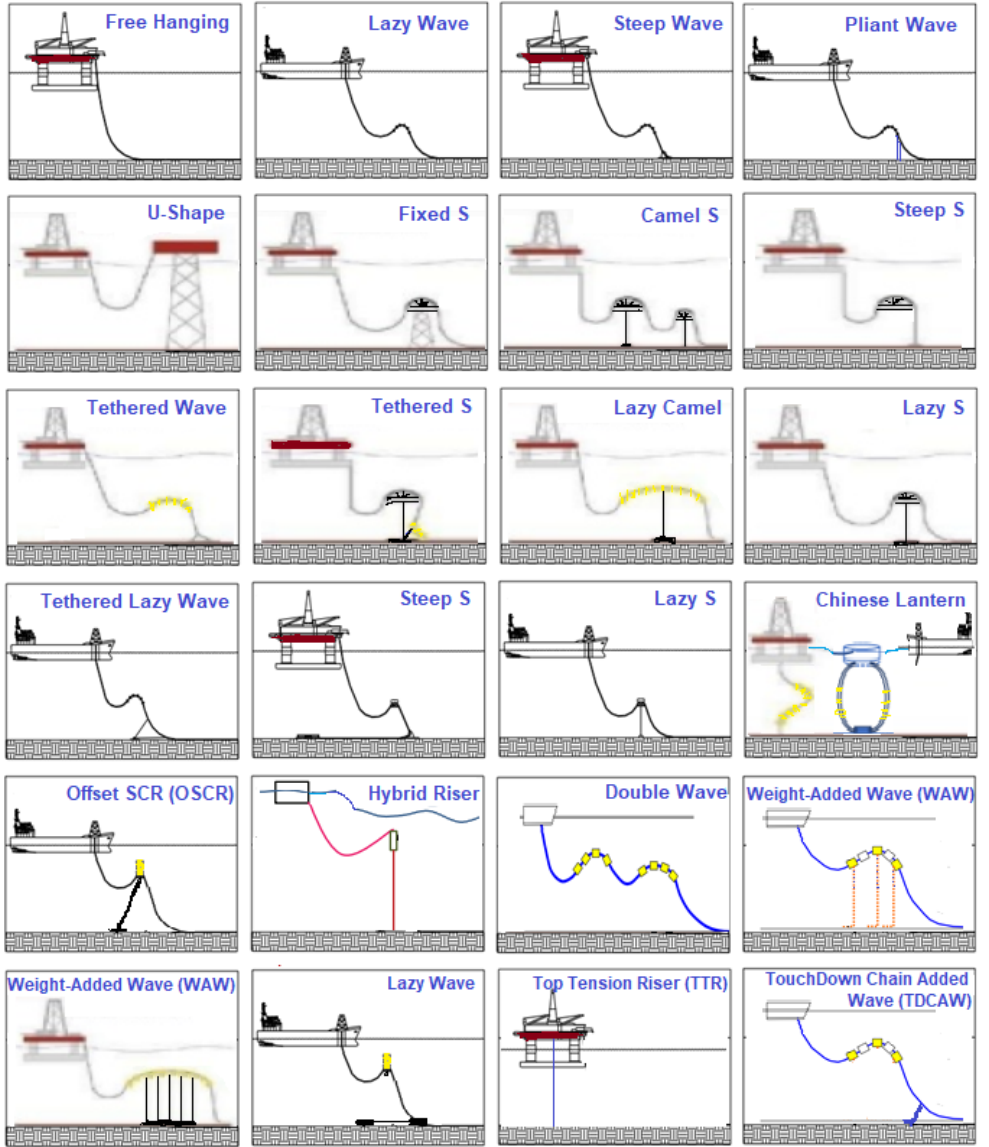
Figure 24. Standard configurations with alternatives for offshore hoses, flexible marine risers, and steel catenary risers (SCRs).